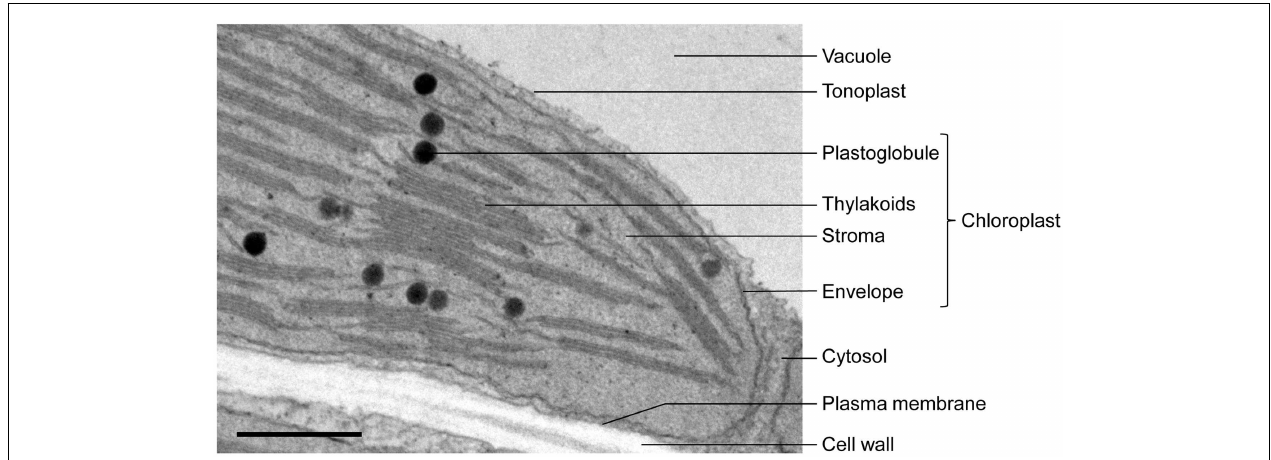
FIGURE 1 | Electron micrograph of an Arabidopsis leaf chloroplast showing plastoglobules in proximity with thylakoids . Bar: 500nm.